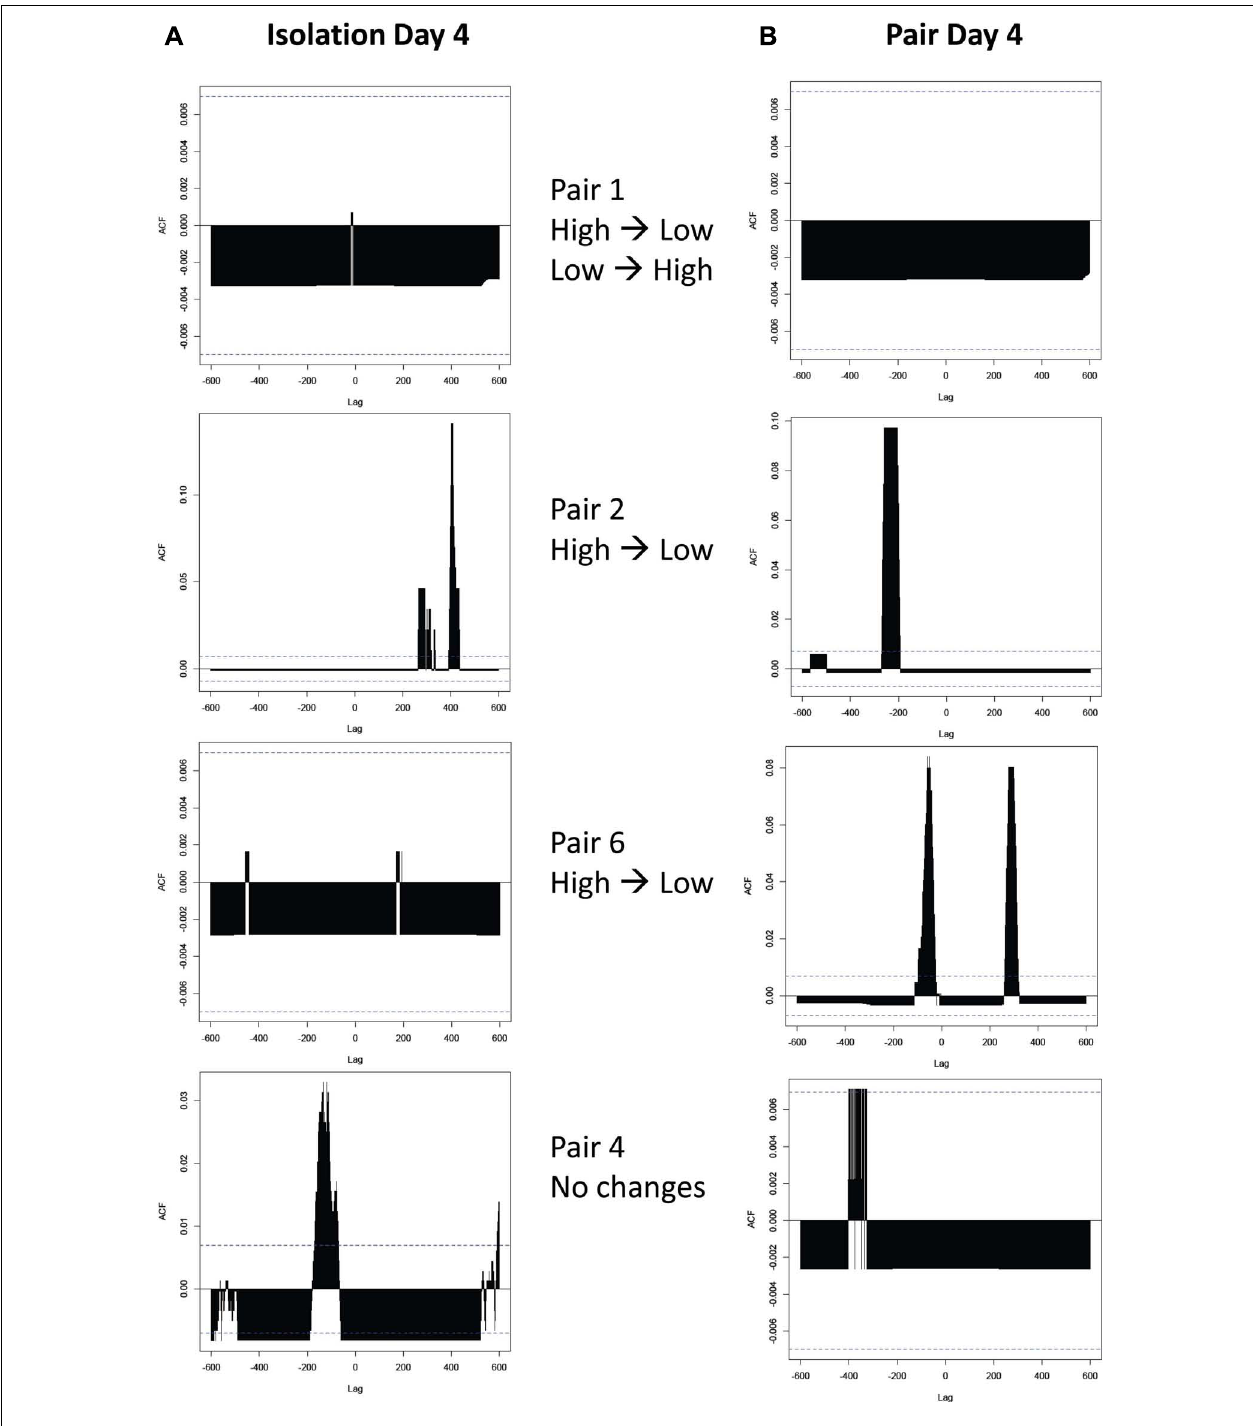
FIGURE 8 | Cross-correlations between ethanol drinking patterns of peers. (A) Correlations between high and low drinkers in isolation, before they have been housed together. (B) Correlations between high and low drinkers in pairs on the fourth day of pair housing.The Y -axis represents the strength of the correlation (autocorrelation function; ACF), while horizontal dashed lines represent the threshold for significance.The X -axis represents “lag” time, in seconds, between drinking events. A significant correlation at a lag time “ h ” indicates that h seconds after the